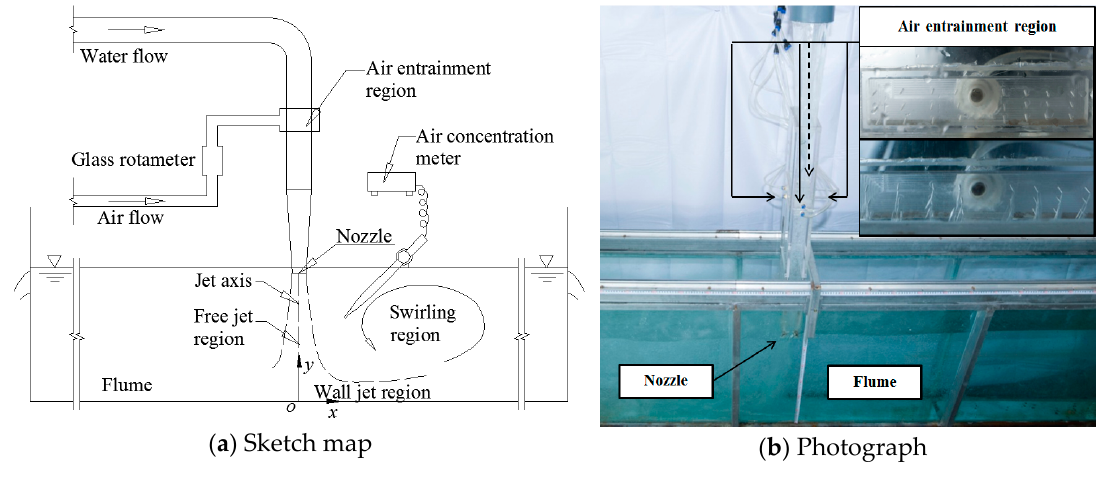
Figure 1. Experimental facility.